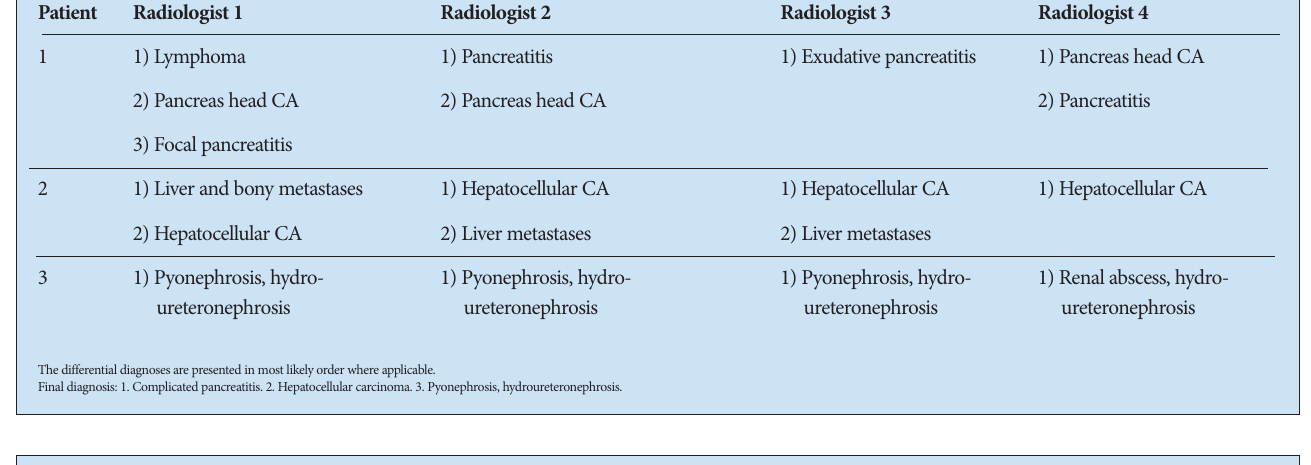
Table II. Indications for CT